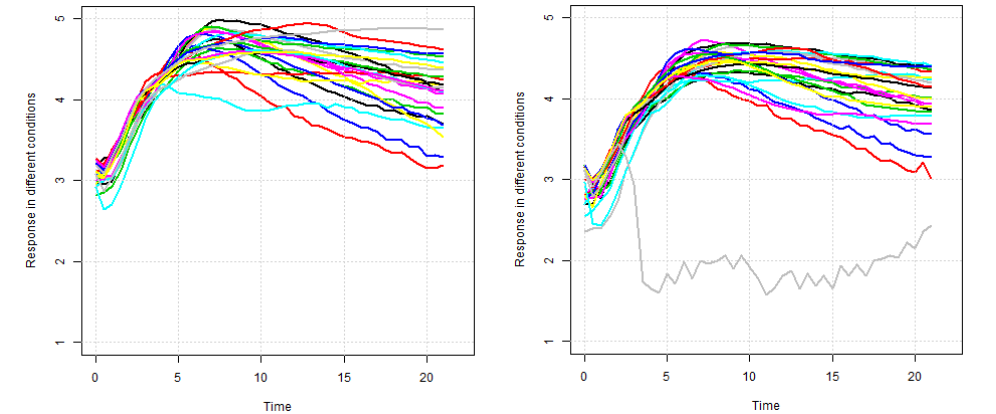
Figure 11. Gene expressions of PA2975(rluc)(B3) ( left ) and PA0573(E6) ( right ).